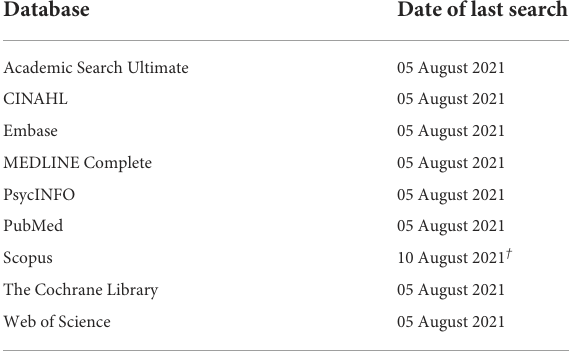
TABLE 1 The databases searched and the date on which the search was